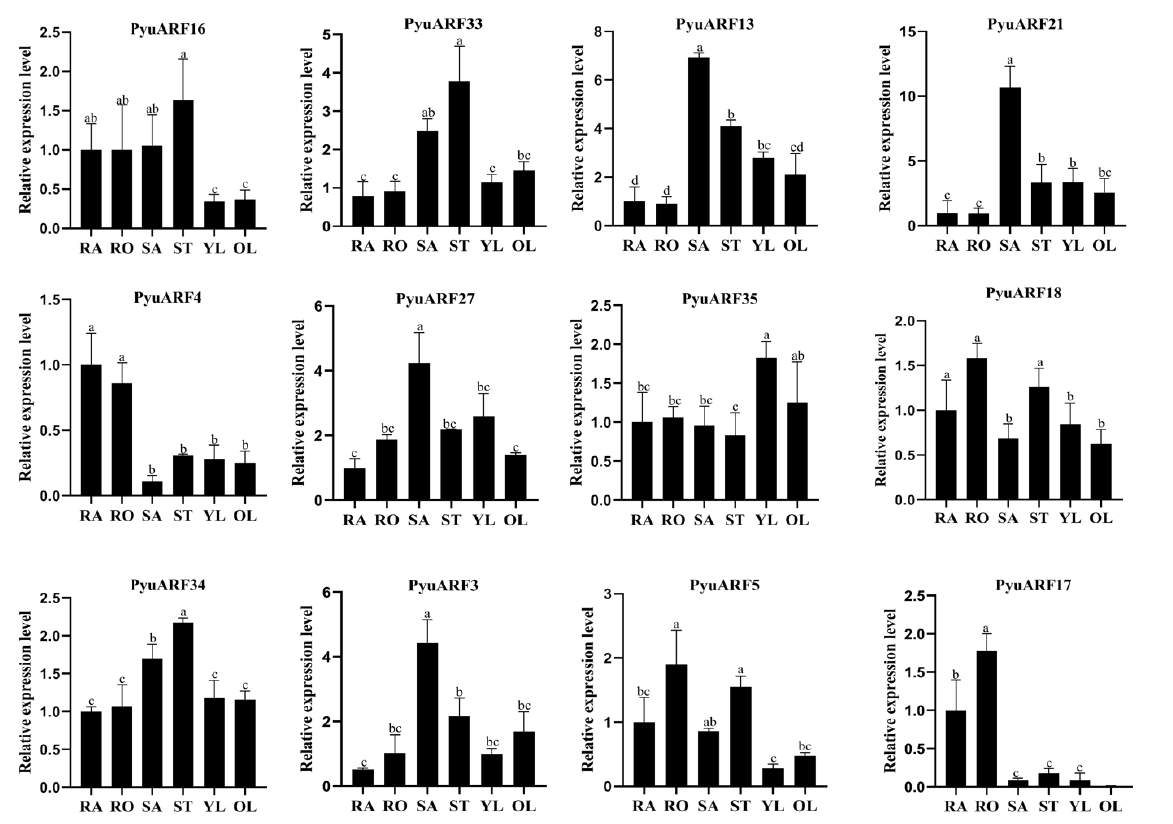
Figure 8. Tissue-specific transcription profiles of 12 PyuARFs with transcriptional activation function. RAM: root apical meristem, Root: mature heel, SAM: shoot apical meristem, Stem: mature Stem, YL: young leaf, OL: mature leaf. The ordinate represents the transcription profiles of the genes in these tissues. Data represent mean ± SD from at least three independent experiments. The same letter indicates a significant correlation at the 0.05 probability level, while different letters indicate no difference.